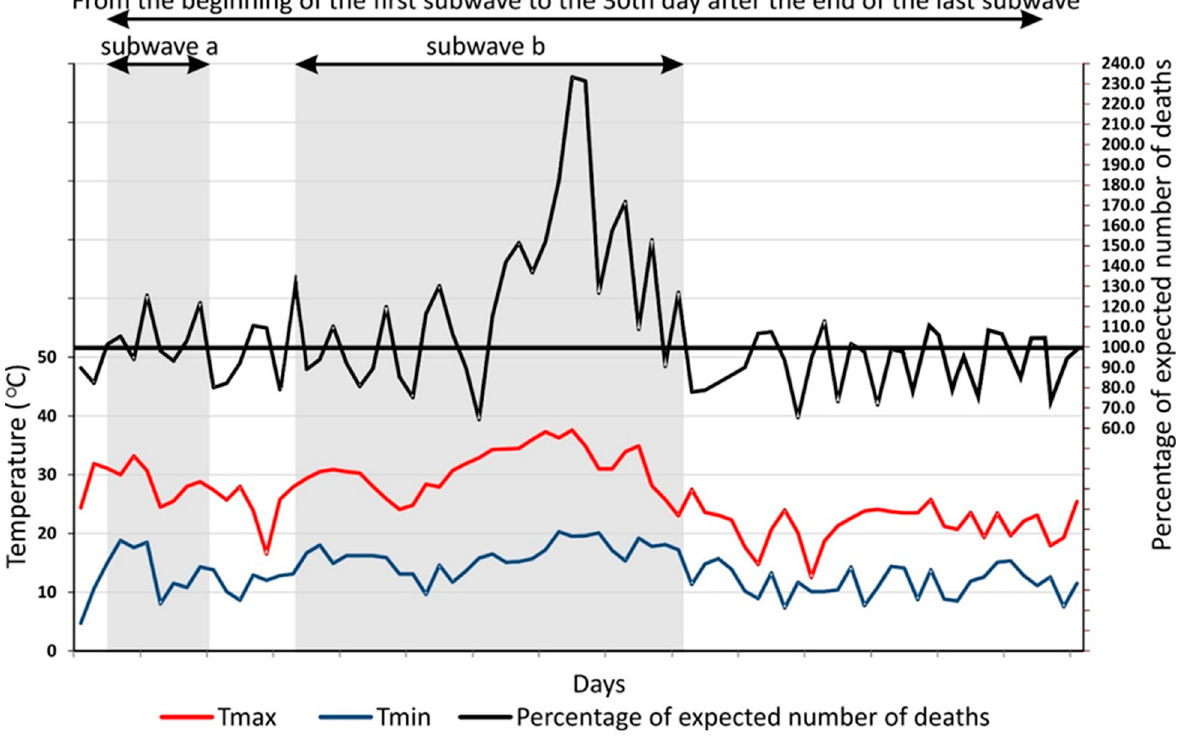
Figure 2. Illustration of the process of determination of time intervals with elevated mortality, related to the occurrence of high values of the air temperature.